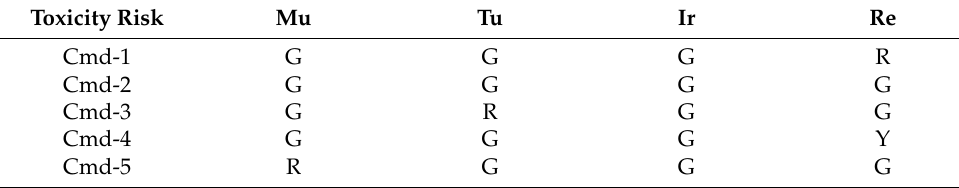
Figure 11. Calculated drug-likeness and drug scores of the best studied Cmds. Table 3. Toxicity risks of the five studied